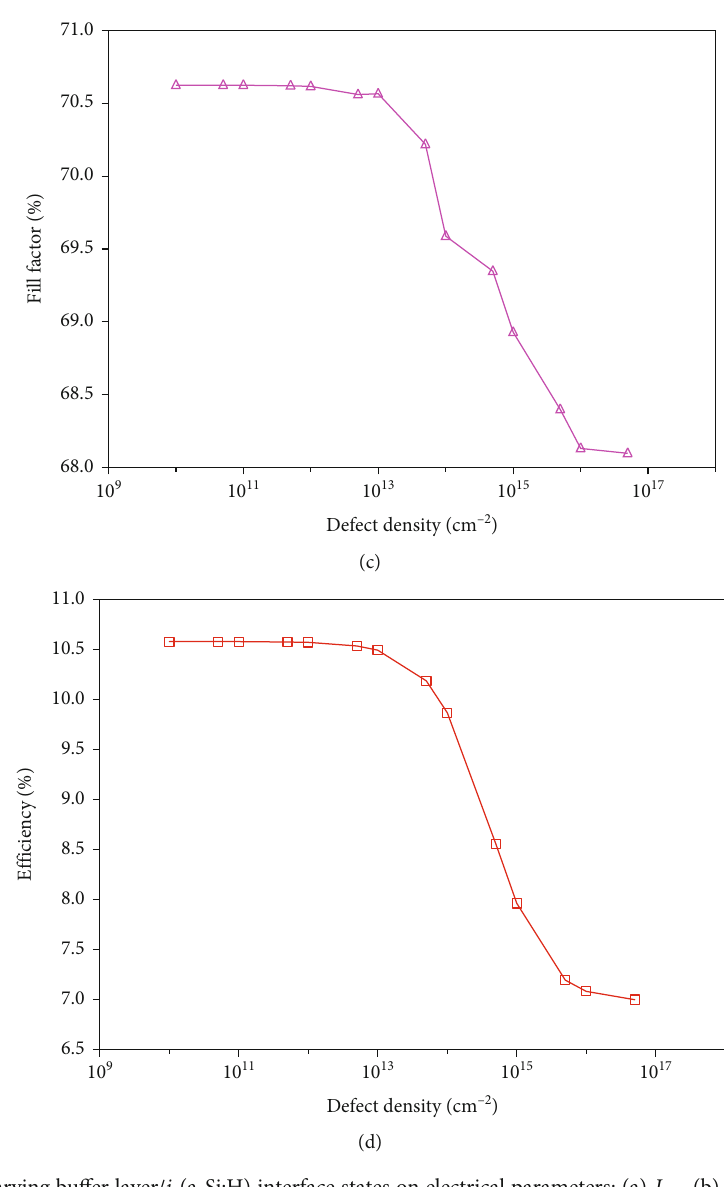
Figure 6: E ff ect of varying bu ff er layer/ i -(a-Si:H) interface states on electrical parameters: (a) J